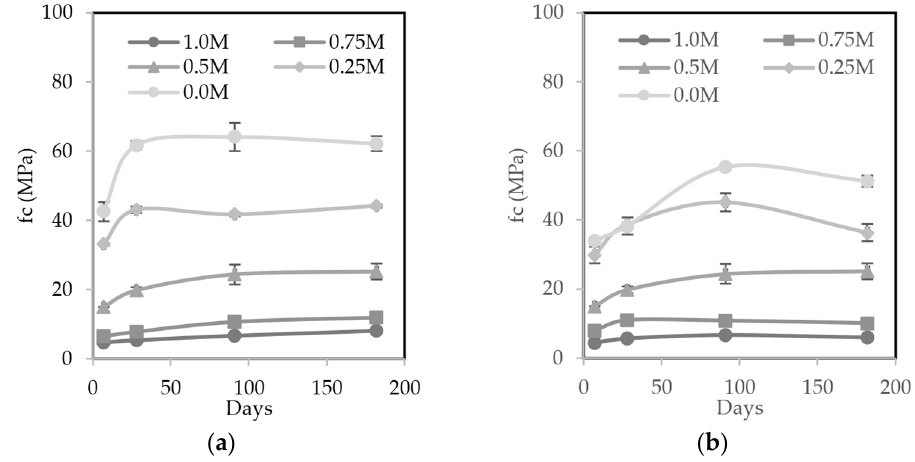
Figure 8 . Compressive strength of: ( a ) OAA mortars and ( b ) CAA